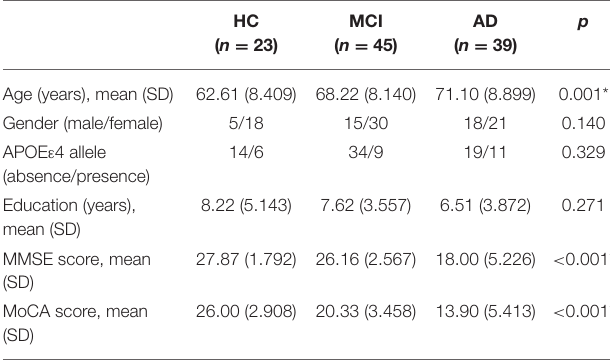
TABLE 1 | General characteristics and clinical data of